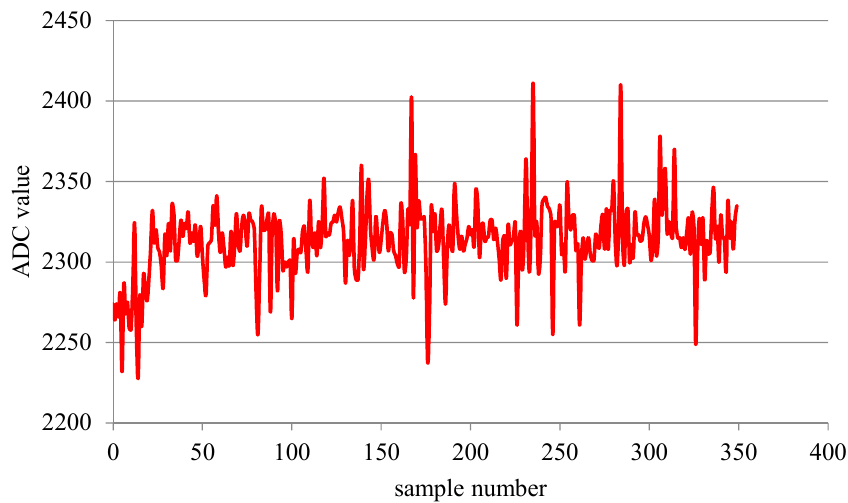
Figure 10. Signal measured by the analogue-to-digital converter (ADC) of the TMS320F2812 system at 700 rpm.